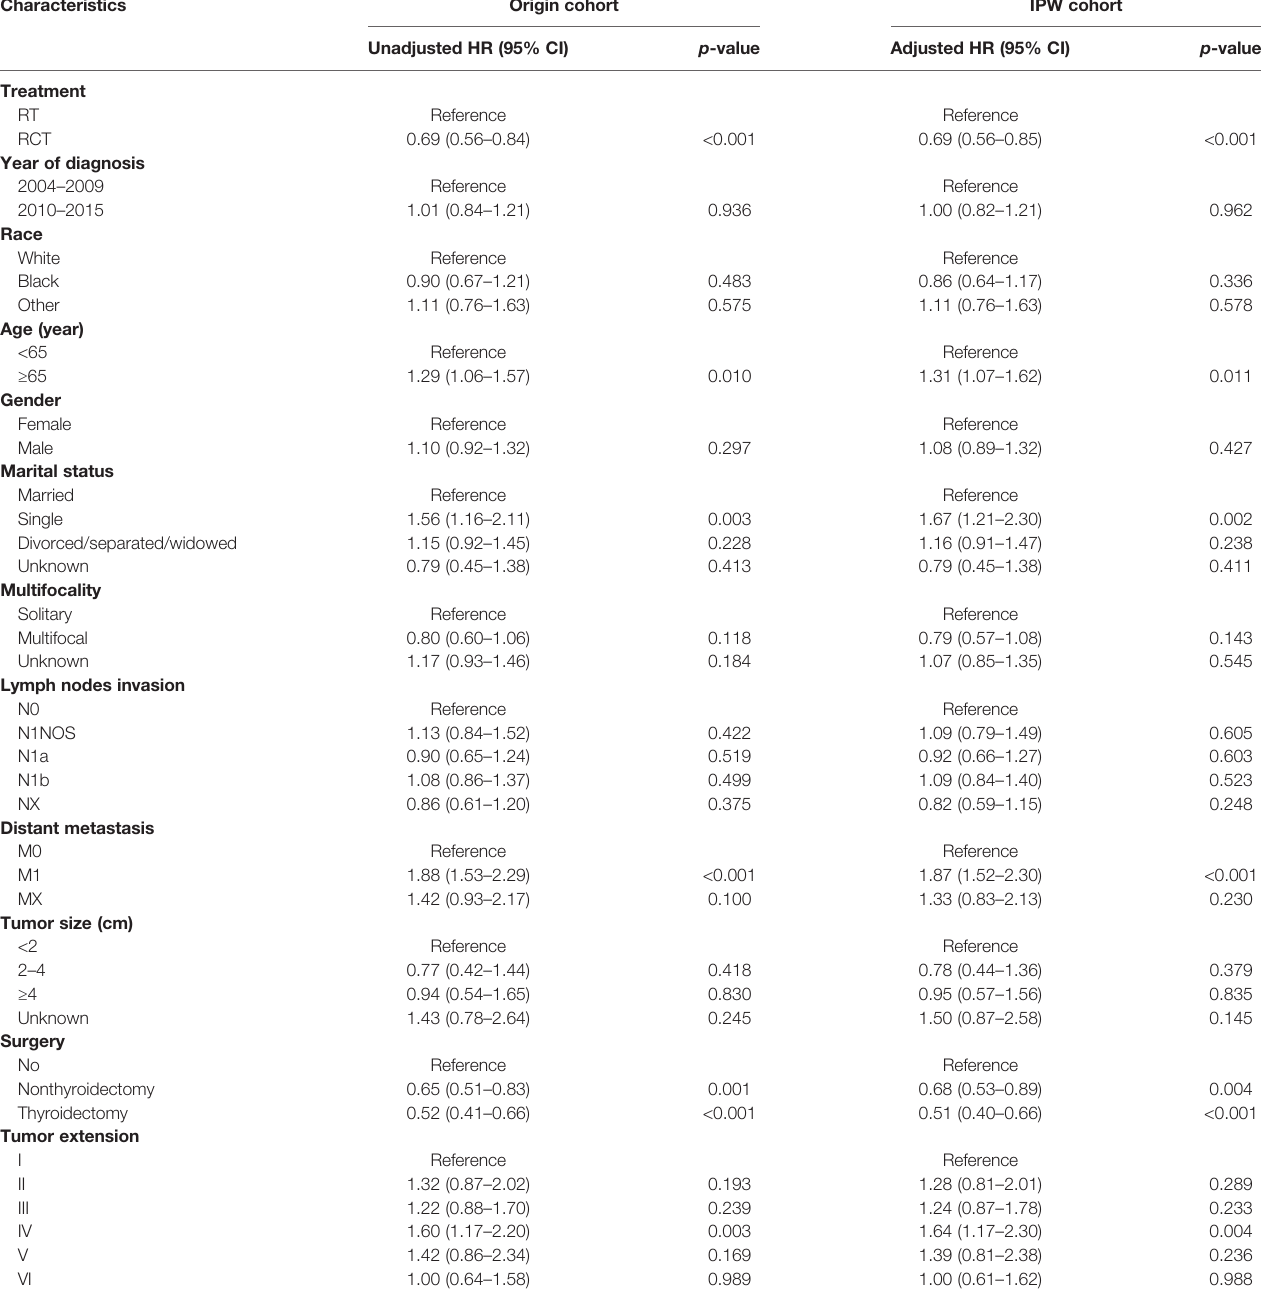
TABLE 2 | Multivariate Cox proportional hazard model of overall survival before and after inverse-probability weighting.